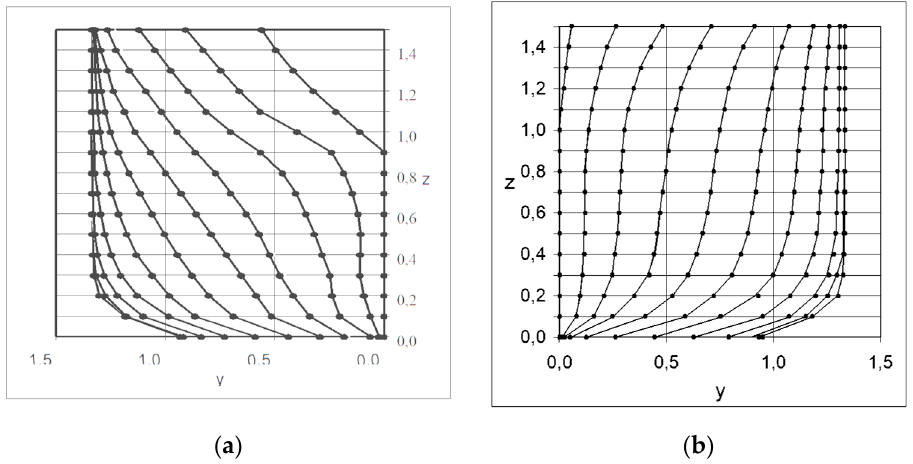
Figure 14. Main waterlines of Todd’s models of series 60.